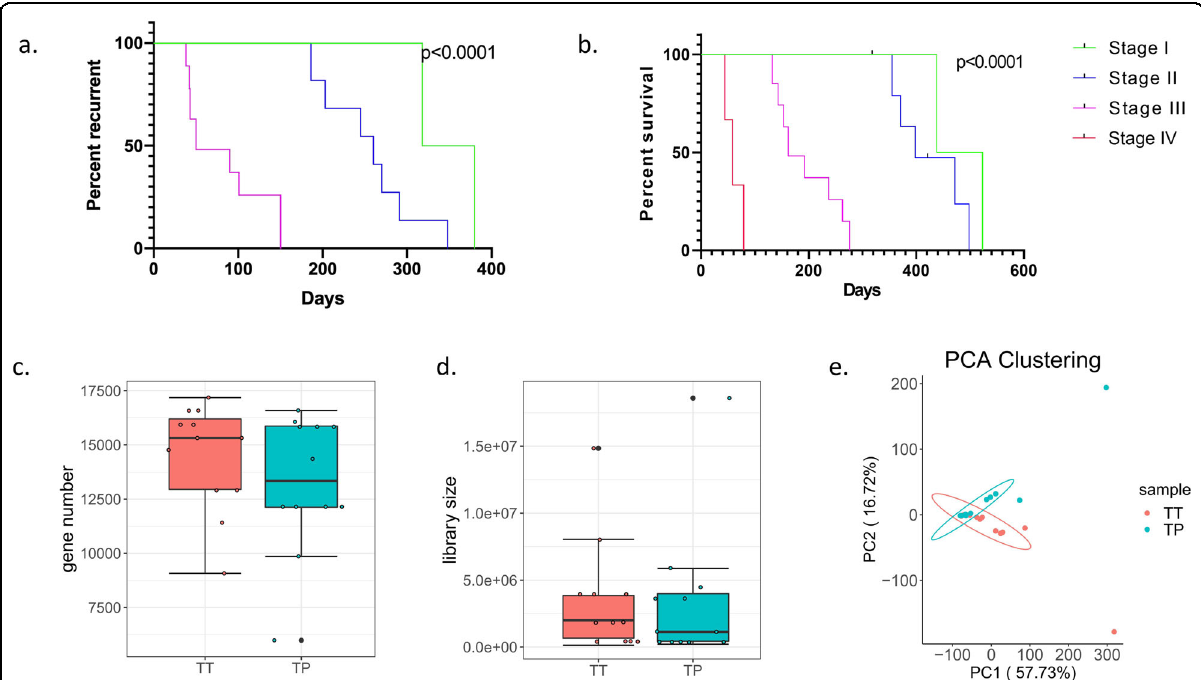
Fig. 1 Follow-up data analysis and sequencing data quality control. a , b The Kaplan – Meier plots showed that the progression-free survival and overall survival of patients decreased signi fi cantly as the patients ’ tumor stage increased. The signi fi cance was tested by Log-rank test. c Quality control for patients ’ tumor (TT) or para-tumor (PT) tissue: the plot showed no signi fi cant different gene number sequenced in two groups. d Quality control for patients ’ tumor (TT) or para-tumor (PT) tissues: library size sequenced showed no signi fi cant difference between two groups. e Quality control for patients ’ tumor (TT) or para-tumor (PT) tissue: PCA clustering showed that there were signi fi cant differences between patients ’ TT and TP tissues (12 samples each for TT or TP group).